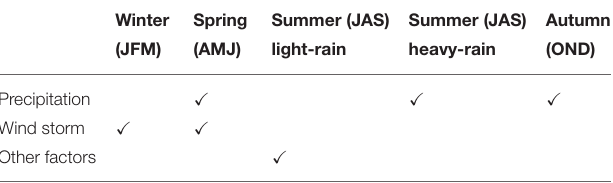
TABLE 2 | Dependence of SLSS occurrence on precipitation, wind, and other factors investigated in the present